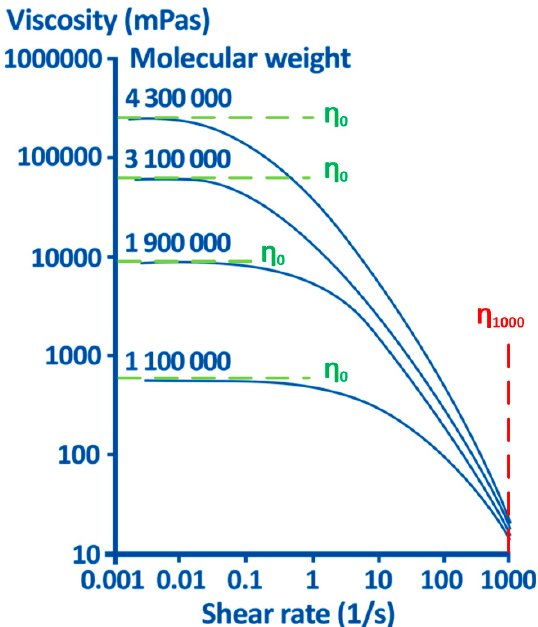
Figure 2. Dependance of the viscosity of 1% aqueous hyaluronan solutions from shear rate, modified from Bothner and Wik [138].